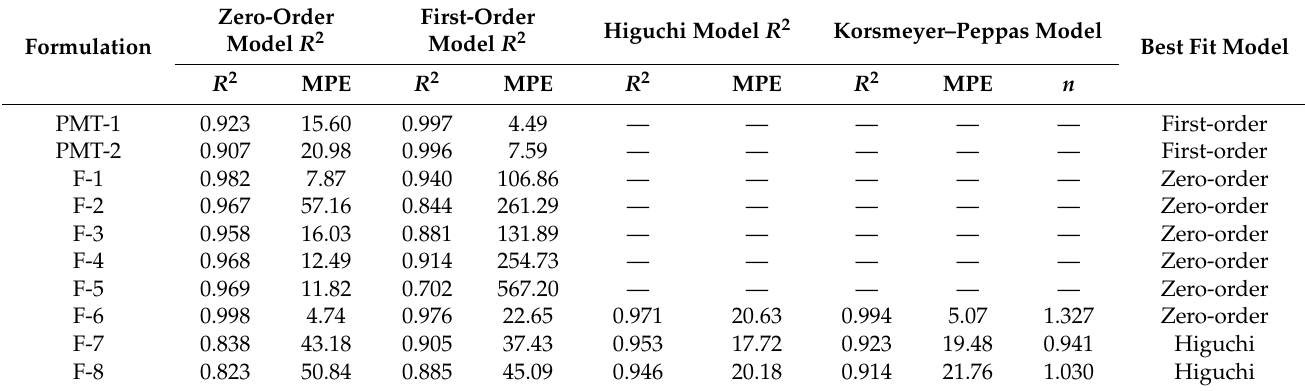
Table 5. Release parameters of all